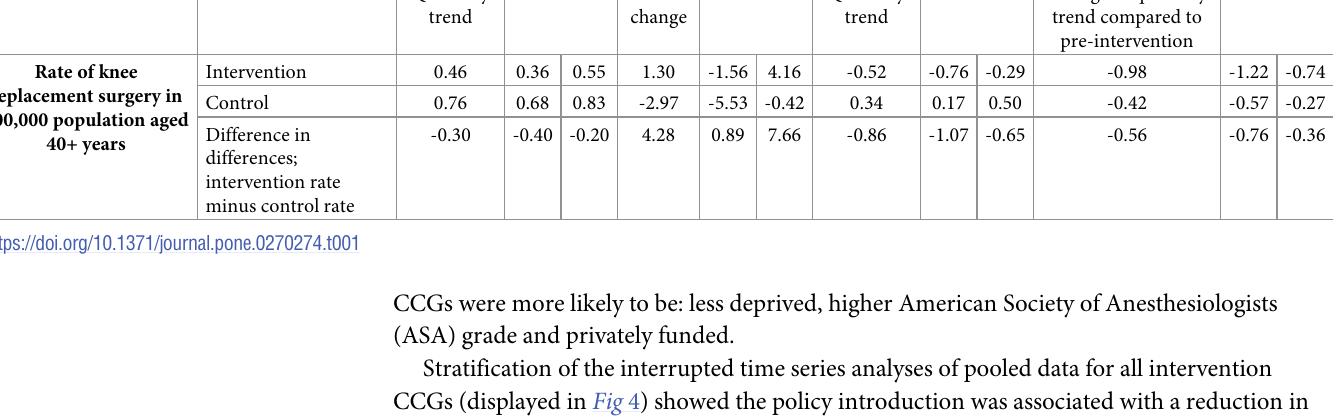
Table 2. Operation rate and patient characteristics of intervention and control CCGs pre- and post- policy introduction.